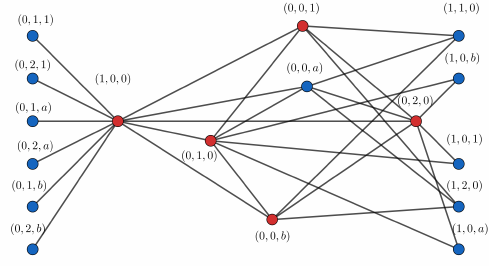
Figure 4. Diagram of the graph Γ ( Z 2 × Z 3 × F 4